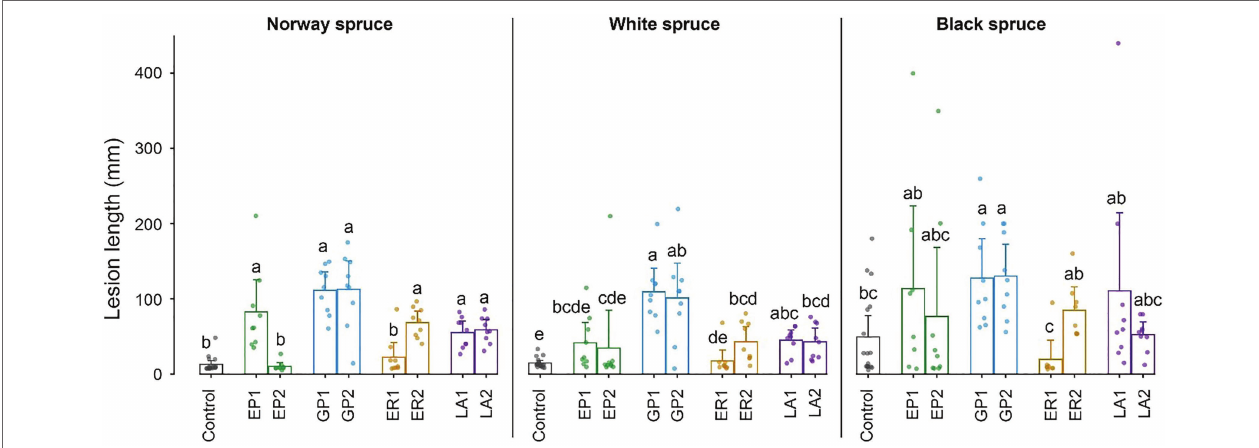
FIGURE 4 | Lengths of necrotic lesions in the inner bark of cut bolts of Norway spruce, white spruce, and black spruce 3 weeks after inoculation with four bark beetle-associated fungi. EP, Endoconidiophora polonica ; GP, Grosmannia penicillata ; ER, Endoconidiophora rufipennis ; and LA, Leptographium abietinum . For each fungus, two isolates were inoculated (e.g., EP1 and EP2; see Table 1 for details). Agar alone (without fungus) was inoculated as a control. Bars show mean values with 95% CIs. Dots show individual replicates ( n = 9). Treatments with different letters (a–e) differed significantly (ANOVA and Tukey’s HSD test with p <